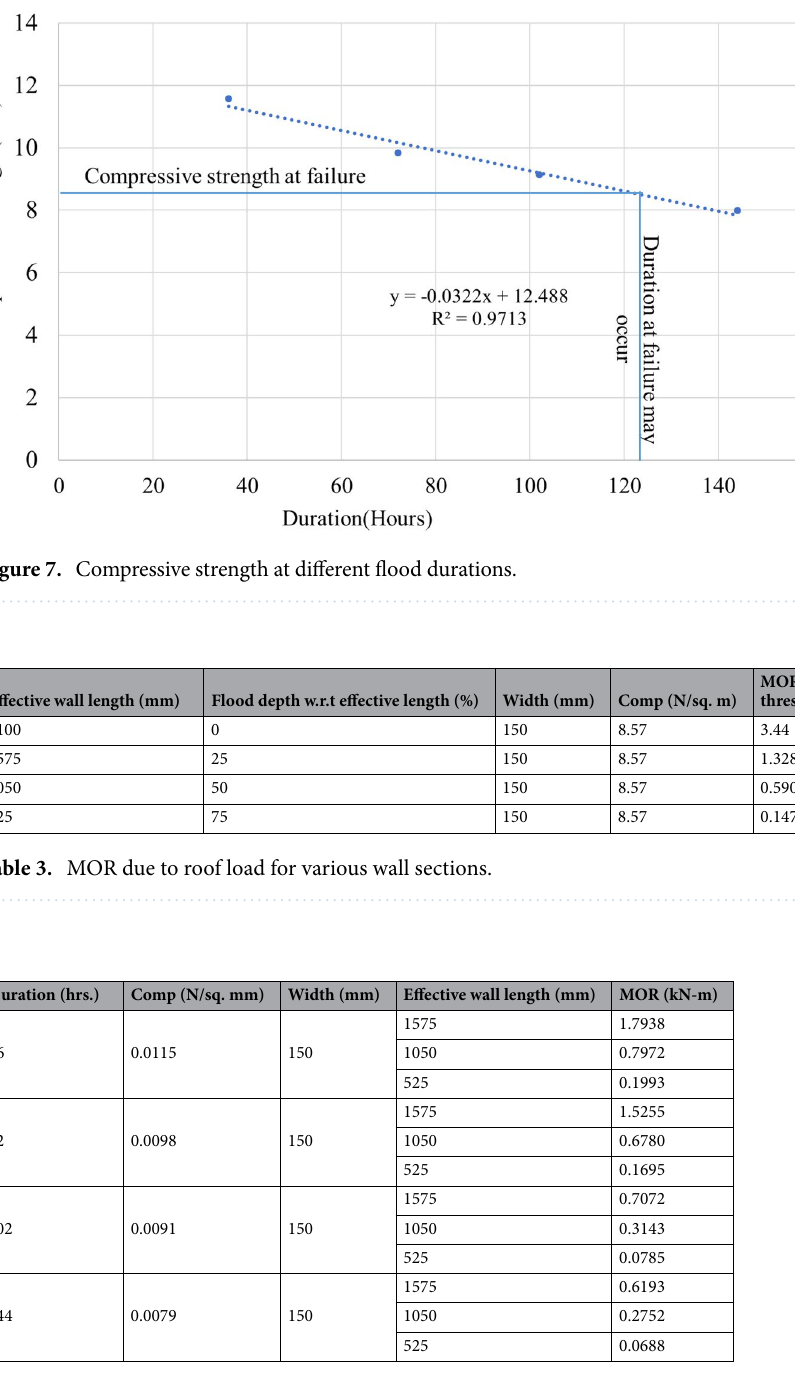
Table 4. Threshold value of MOR estimated using the compressive strength.